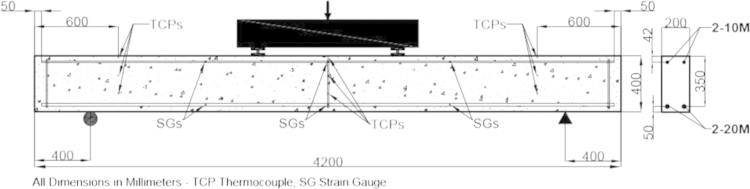
Internal reinforcement, test configuration and instrumentation.